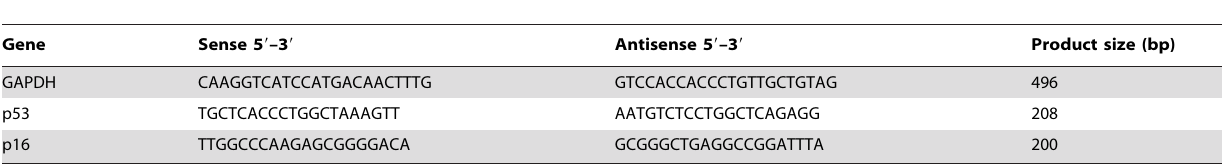
Table 1. Primer sequences for GAPDH, p53 and p16 mouse cDNAs.